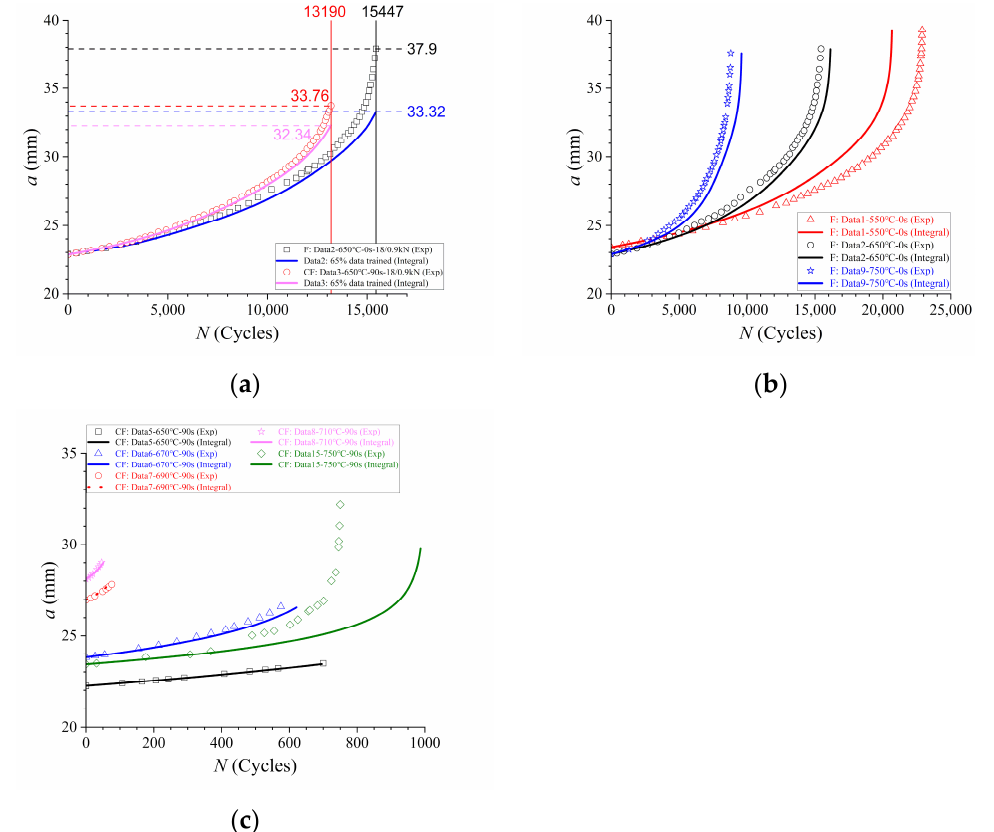
Figure 8. Prediction of a - N curves using NNK method for: ( a ) fatigue condition (Data2–650 °C-0s-18/0.9 kN) and creep-fatigue condition (Data3–650 °C-90s-18/0.9 kN), respectively; ( b ) fatigue condition with different elevated temperatures (550/650/750 °C-0s-18/0.9 kN); and ( c ) creep-fatigue condition with different elevated temperatures (650–750 °C).